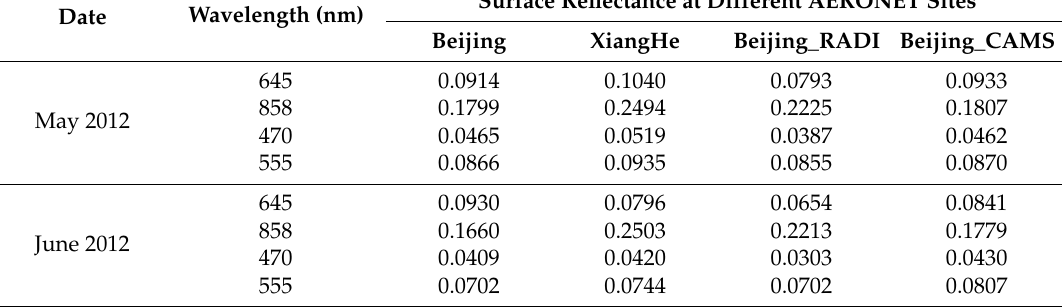
Table 1. The magnitude of the surface reflectance at the four AErosol RObotic NETwork (AERONET) sites on different